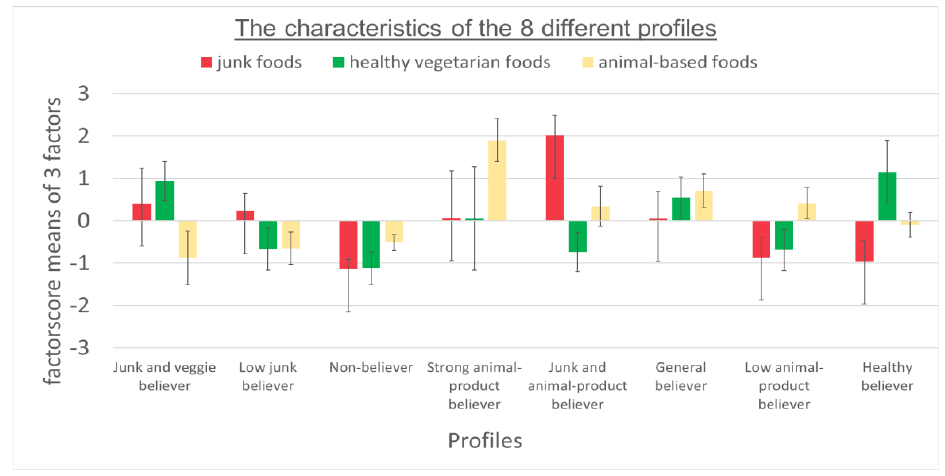
Figure 1. Profiles that were identified in the total sample through latent profile analysis. Error bars represent one standard error.